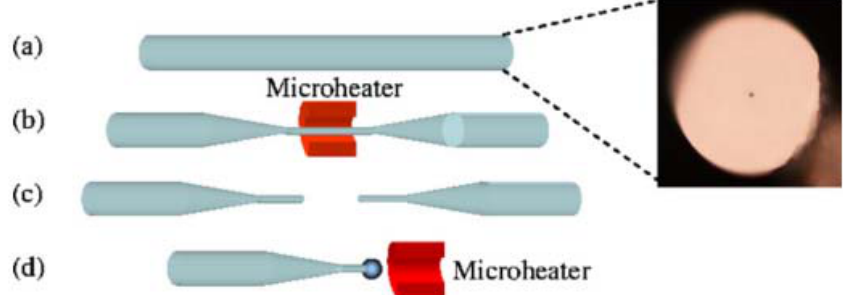
Figure 3. Schematic diagram of the experimental setup used for making a lead silicate microsphere. ( a ) Cross-section of lead silicate fiber; ( b ) a fiber is tapered by using a microheater; ( c ) the uniform waist of the tapered fiber is cleaved; ( d ) a lead silicate microsphere is formed. Reprinted/Adapted with permission from [64].